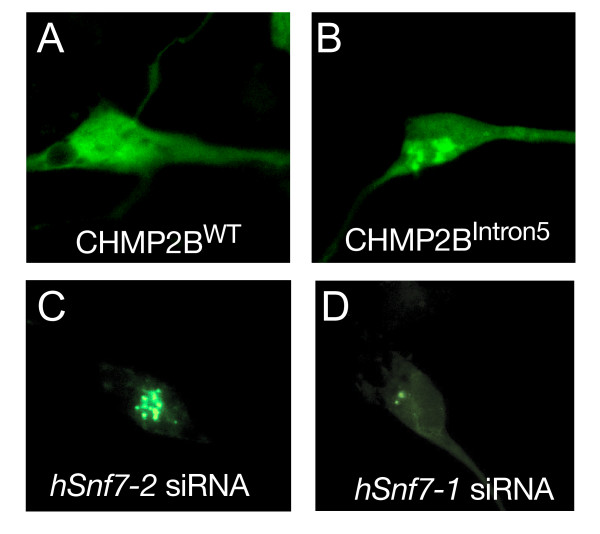
Autophagosome formation in hESC-derived human neurons. (A) A CHMP2BWT-transfected human neuron. (B) Autophagosomes accumulate in CHMP2BIntron5-transfected human neurons, as indicated by GFP-LC3. (C) SiRNA knockdown of hSnf7-2 in human neurons leads to autophagosome accumulation, as indicated by GFP-LC3. (D) SiRNA knockdown of hSnf7-1 in human neurons leads to autophagosome accumulation, as indicated by GFP-LC3.